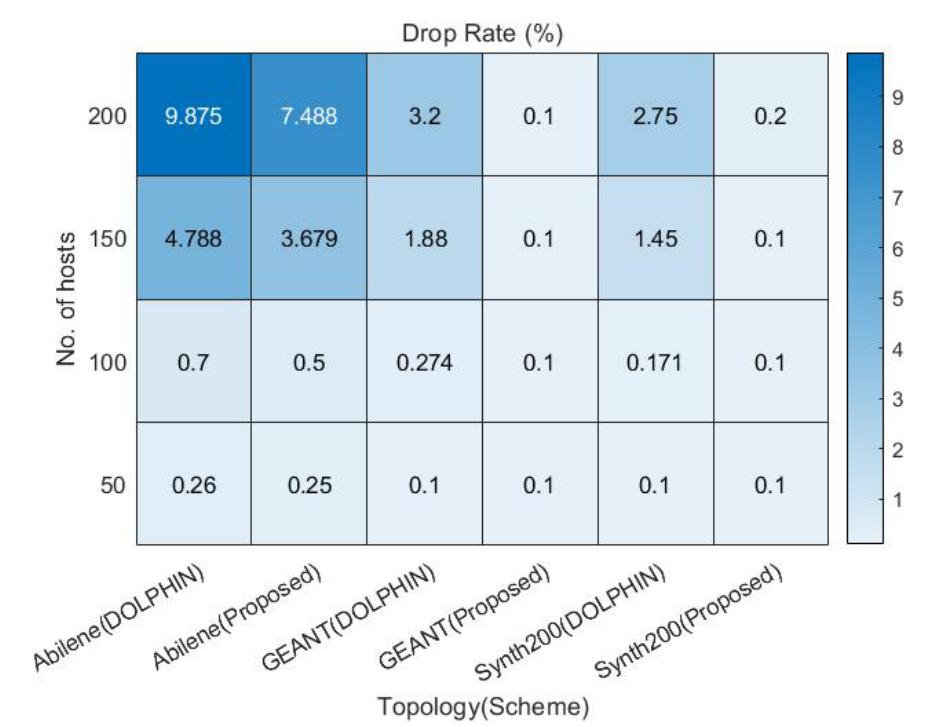
Figure 11. Representation of the backlog and delay